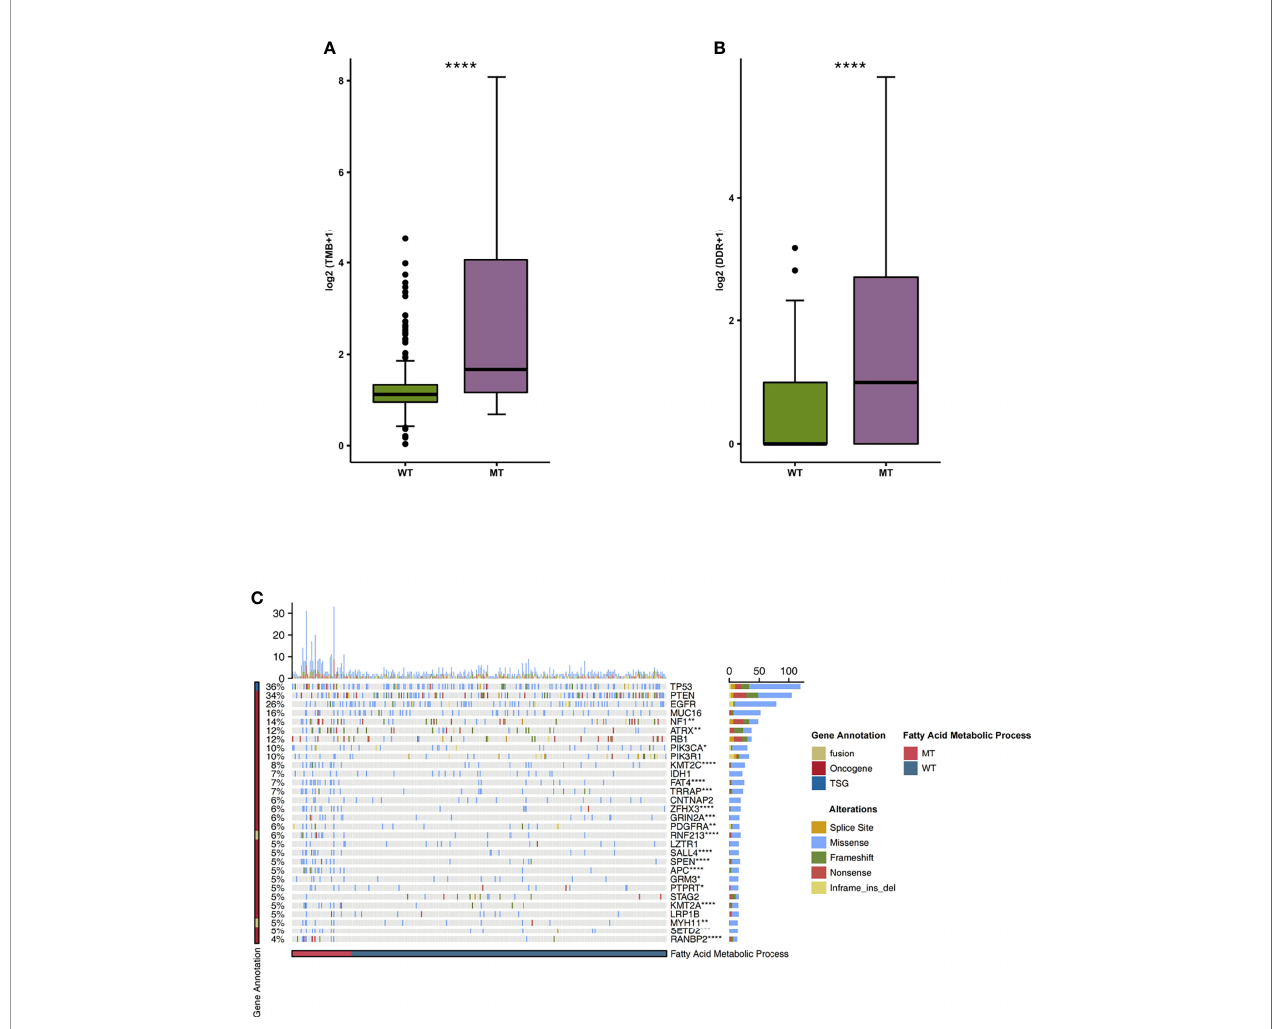
FIGURE 4 | (A) A comparison of the TMB levels of the fatty acid metabolic processes of the MT and WT groups. (B) A comparison of the mutation counts of DDR signaling of the fatty acid metabolic processes of the MT and WT groups. (C) The mutational landscape of the top 30 mutated driver genes in the fatty acid metabolic processes of the MT and WT groups. MT, mutant-type; WT, wild-type; TMB, Tumor mutation burdens; DDR, DNA damage repair. *P < 0.05; **P < 0.01; ***P < 0.001; ****P <